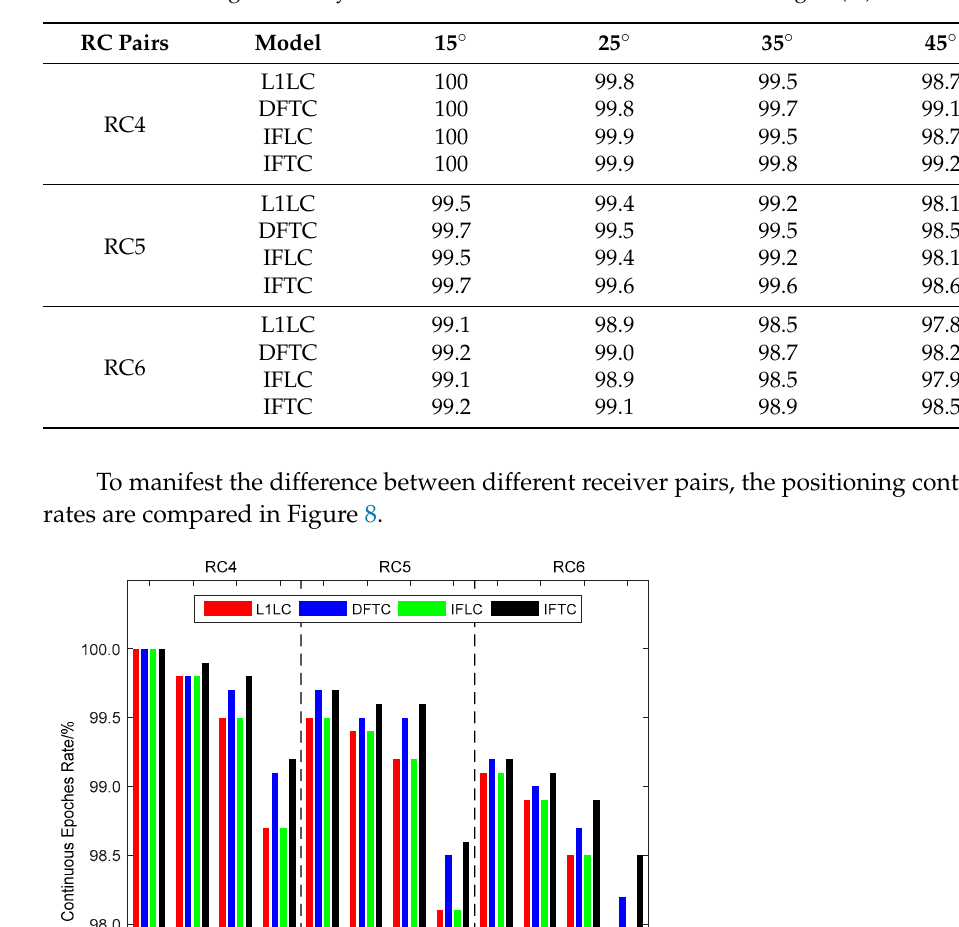
Table 9. Positioning continuity rate results with different cutoff elevation angles (%).